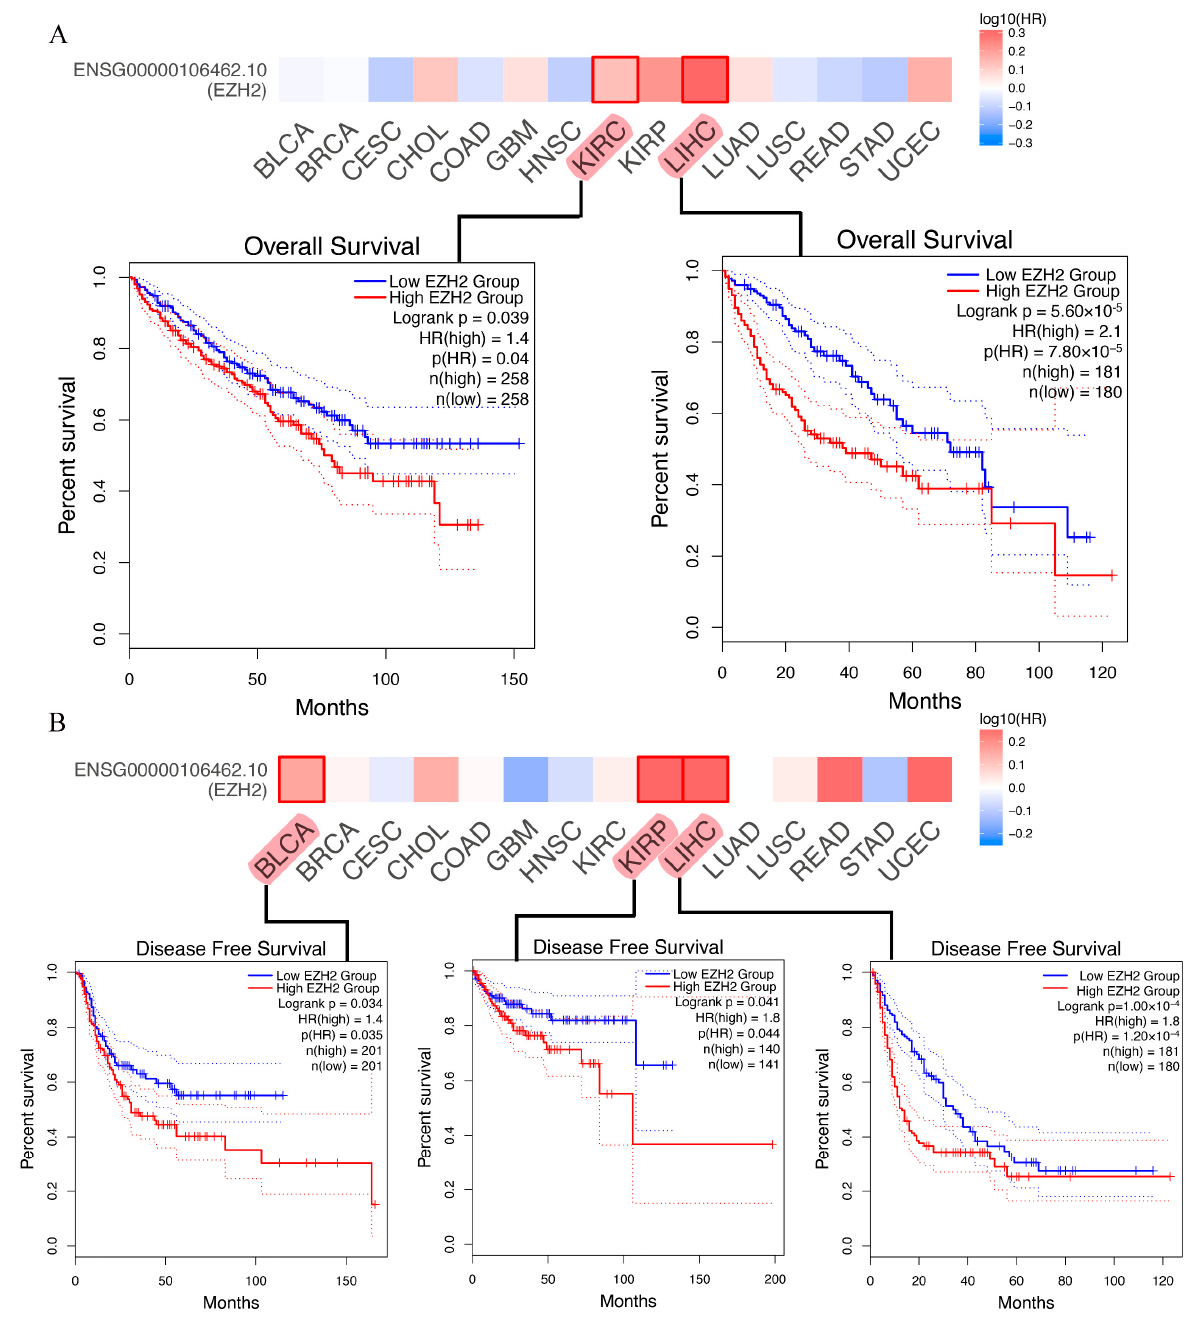
Figure 3. Kaplan-Meier survival curves of human cancers with high and low EZH2 expression analyzed by the GEPIA2 and Sangerbox databases. ( A ) Overall survival (OS). ( B ) Disease-free survival (DFS).